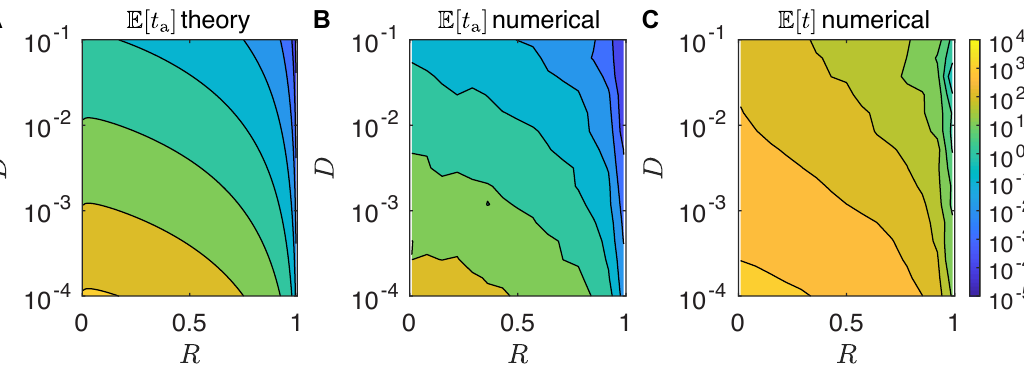
Figure 4. Male arrival time distributions evaluated in { R , D } phase space, where R = r mate / r 0 . ( A ) Mean first arrival times E [ t a ] calculated from Equation(13a) for N = 1000 moths. ( B ) Mean first arrival times E [ t a ] calculated from numerical simulations with N = 1000 arrivals and t call = 1800 s (Section 4.1). ( C ) Mean arrival times E [ t ] calculated from numerical simulations. Mean first arrival times E [ t a ] are the lowest for large diffusivities D and for R → 1, as can be expected. Note the nine orders of magnitude variation for E [ t a ] across the { R , D } ranges considered. The mean arrival time E [ t ] is generally much larger than E [ t a ] and only spans three orders of magnitude in the same { R , D }